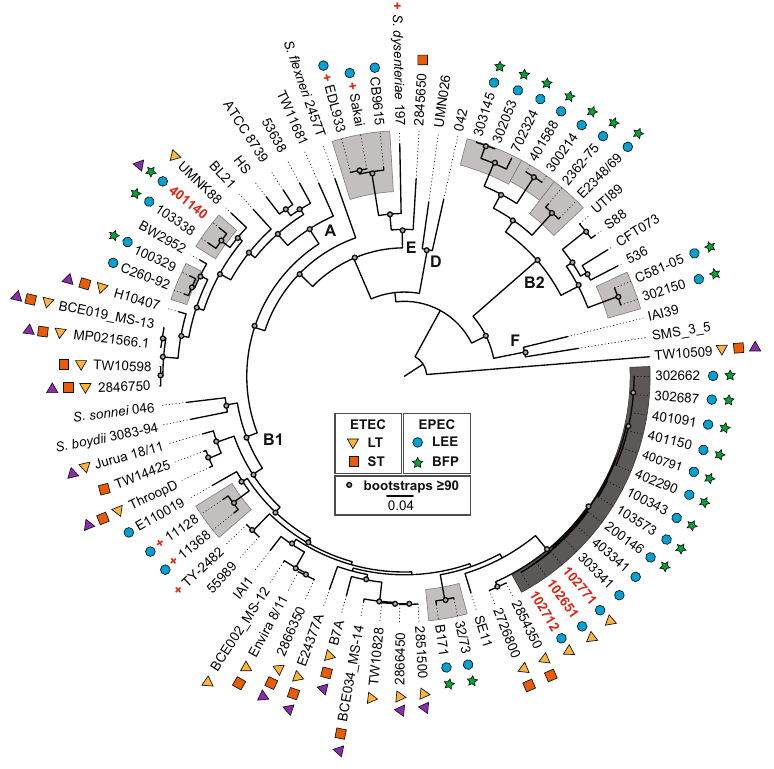
Figure 1. Phylogenomic analysis of the EPEC/ETEC hybrid isolates. The whole-genome sequences of the EPEC/ETEC hybrid isolates were compared with previously sequenced E. coli and Shigella genomes listed in Table S1 using a single nucleotide polymorphism (SNP)-based approach as previously described 17, 43 . SNPs were detected relative to the completed genome sequence of the laboratory isolate E. coli IAI39 using the In Silico Genotyper (ISG) 43 . A total of 159,709 conserved SNP sites, which were present in all of the genomes analyzed, were concatenated into a representative sequence for each genome. A maximum-likelihood phylogeny with 100 bootstrap replicates was inferred using RAxML v.7.2.8 56 . The presence of E. coli virulence genes in each of the genomes is indicated by symbols as follows: LT (yellow triangle), ST (orange square), LEE (blue circle), BFP (green star), EatA (purple triangle), and Shiga-toxin (red plus sign). The letters (A, B1, B2, D, E, and F) designate the E. coli and Shigella phylogroups that were previously defined 35, 36 . The EPEC/ETEC hybrid isolates are indicated in bold red. The phylogenomic lineages of the LEE-containing E. coli are indicated in light grey, while the EPEC7 lineage is in dark grey. Bootstrap values ≥ 90 are designated by a grey circle. The scale bar represents the distance of 0.05 nucleotide substitutions per site.